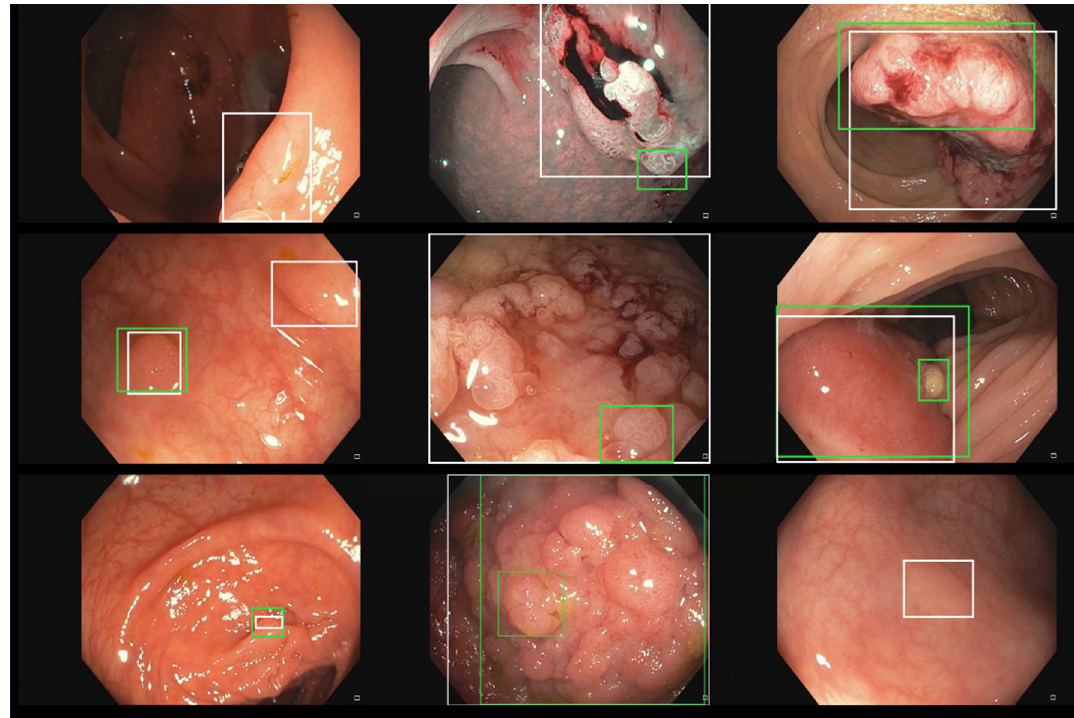
Figure 6. Incorrect prediction examples of our detection model over the different splits of the PICCOLO dataset. From left to right, there are three examples taken from the train, validation, and test splits. Predicted boxes are depicted in green, whereas ground truth boxes are in white.